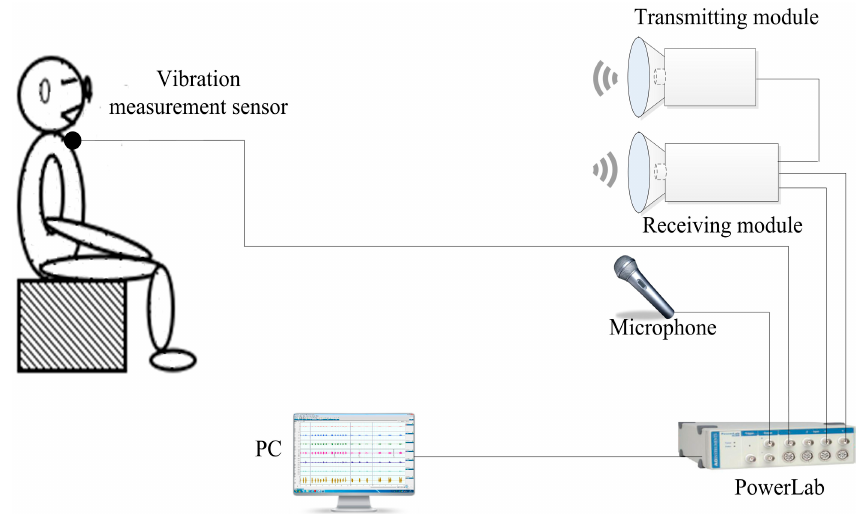
Figure 2. Schematic of the experimental system for detecting the vocal vibration signal.